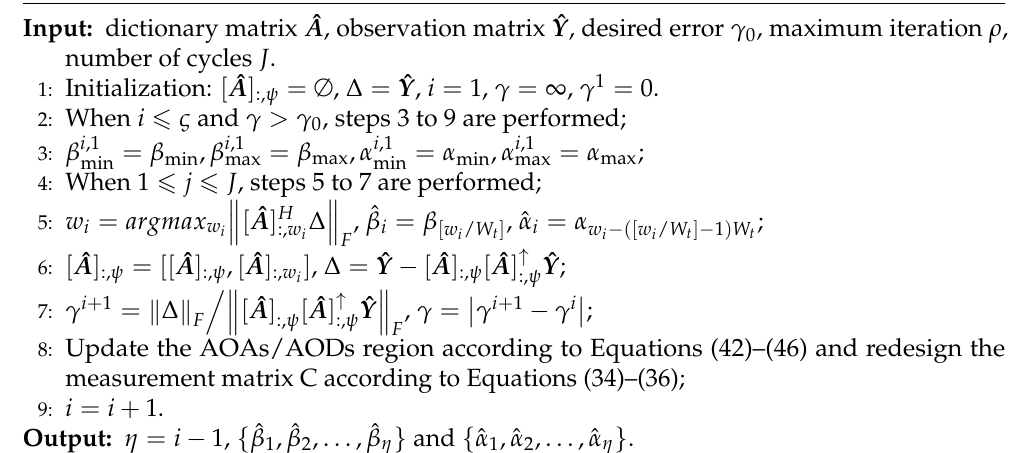
Algorithm 2 The proposed dictionary matrix adaptive iterative update algorithm.